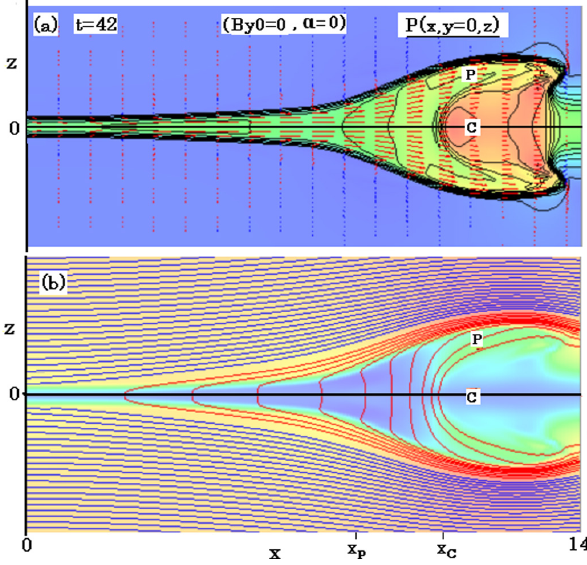
Fig. 2. (a) Plasma flow vectors and plasma pressure disribution with contour interval of 0 . 15, and (b) magnetic field lines passing through the x- and z-axes with the distribution of | B x | in color, in the y = 0 [ (x,z) ] plane at time t = 42 for the case of B y0 = α = 0; here, X P and X C indicate the plasmoid backward end and the plasmoid center, respectively, and P and C indicate, respectively, the plasmoid reconnection region and the plasmoid core region. The color from blue to red indicates the quantity magnitude from its minimum to the maximum; in what follows, all the similar figures are shown in this